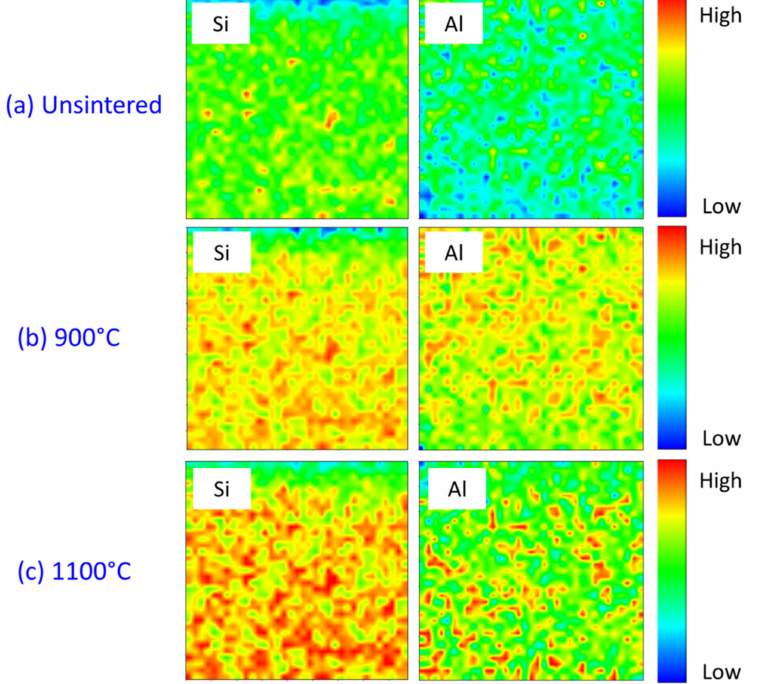
Figure 8. Micro-XRF elemental distribution maps of Si and Al in kaolin geopolymer ceramic at various sintering